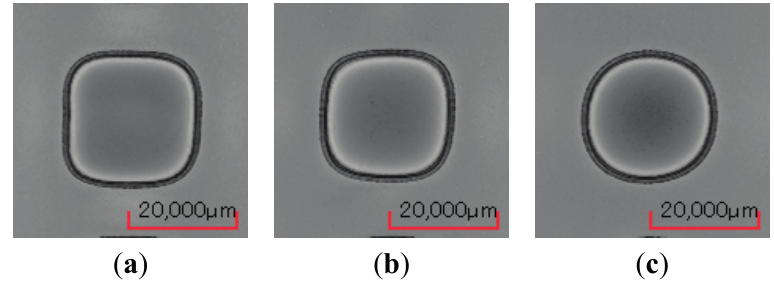
Figure 8. Behavior of the quality index for deviation from the focal position for FBS-1 and FBS-2. ( a ) Free aperture/ v = 0.19. ( b ) r = 1.6/ v = 0.22. ( c ) r = 0.6/ v =